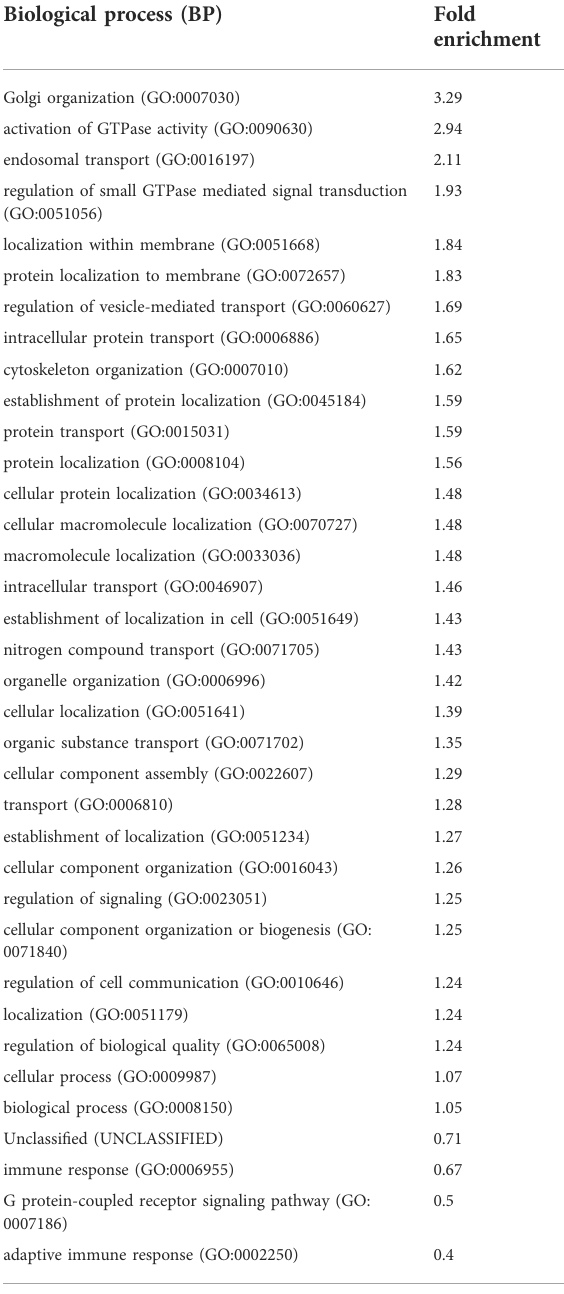
TABLE 4 Predicted target genes of selected upregulated piRNAs during the course of RSV infection. piRNAs